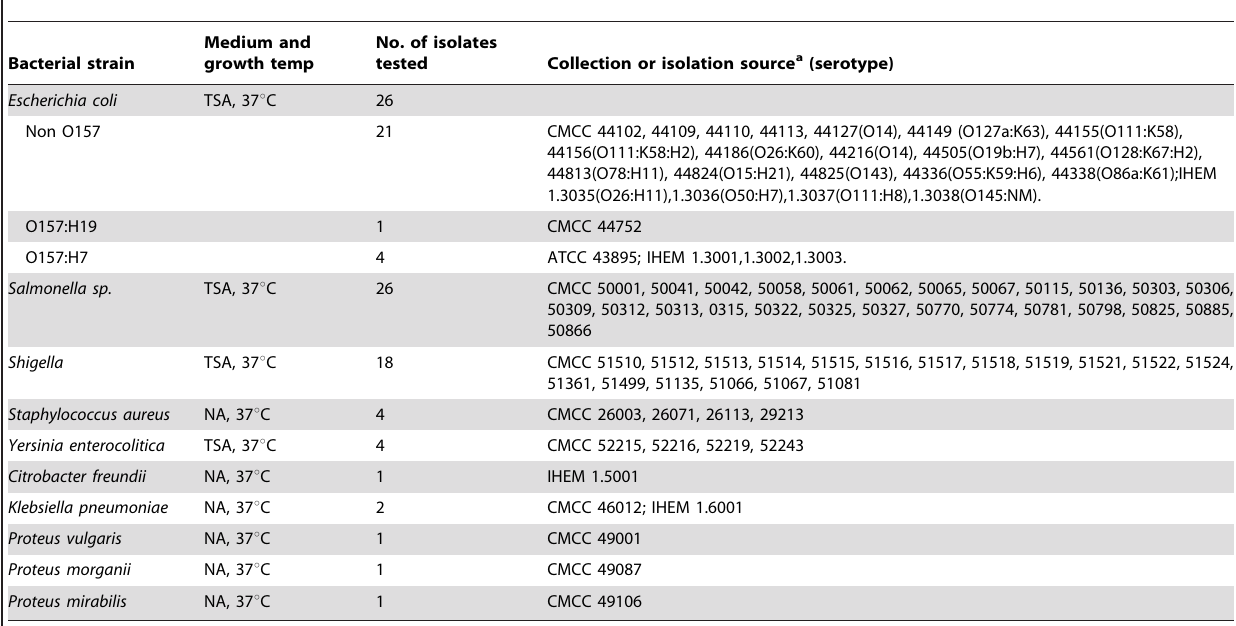
Table 1. Bacterial strains used in the study.